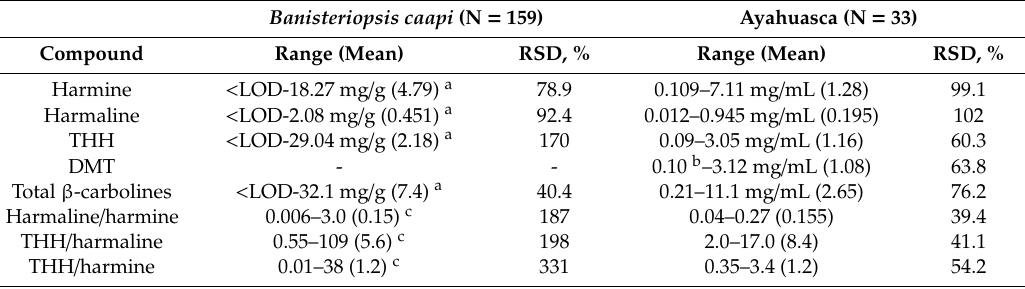
Table 1. Levels of alkaloids found in B. caapi and ayahuasca samples collected in various Brazilian regions from 2016 to